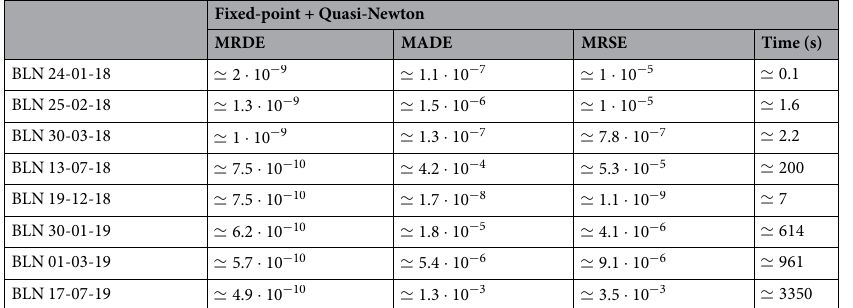
Table 8. Performance of the algorithm coupling fixed-point and quasi-Newton to solve the system of equations defining the (undirected version of the) CReM, on a set of real-world WUNs. The algorithm stops 8 L ( 10 θ) because the condition is satisfied. As the results reveal, it is more accurate that the single 2 − � ||∇ || ≤ methods composing it and much faster than the quasi-Newton one - for some snapshots, more accurate and even faster than Newton’s method. Only the results corresponding to the best choice of initial conditions are